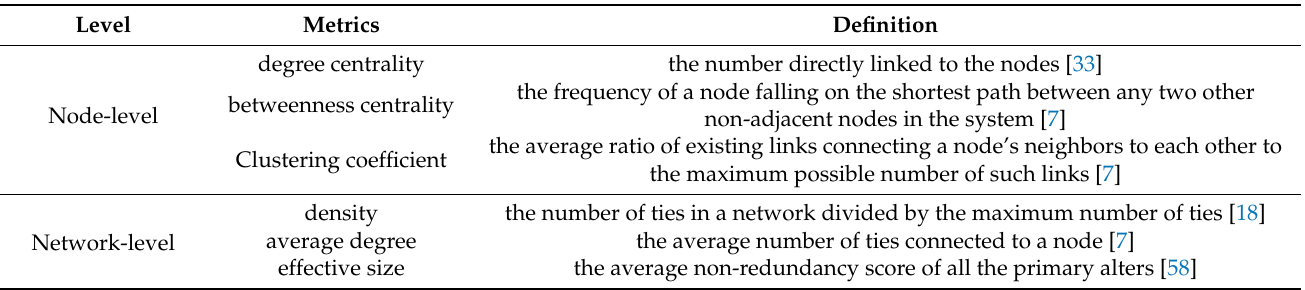
Table 1. Selected network properties in Model